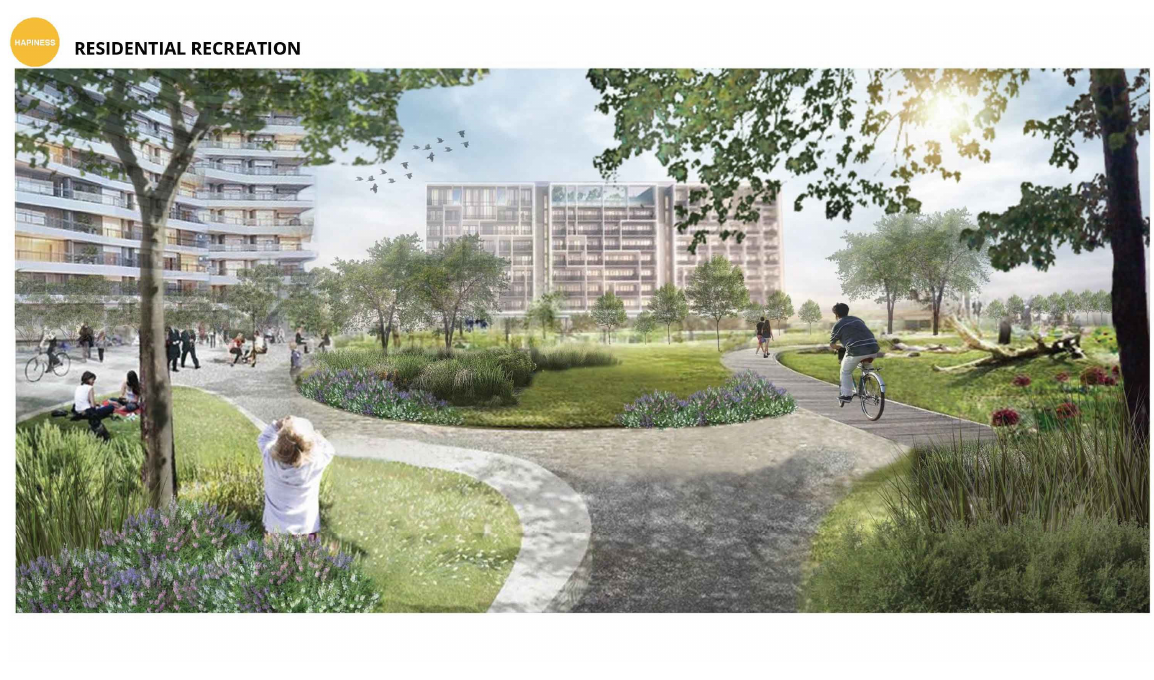
Figure 13. ( a ) Fora Estuary focus on integrated but diverse green space/public space, water-sensitive urban design, and smart living. Graphics credits to Kanokwan Srisamer, Manus Janthik, Panyawat Terdkeat, Wipawee Khantikittikul, UD327 class. ( b ) Design collage of the Fora Estuary, showing the